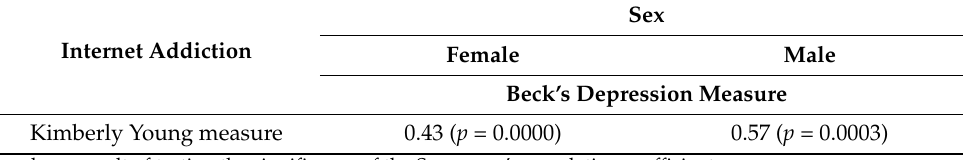
Table 5. Computer addiction and depression severity—Spearman’s rank correlation coefficient.